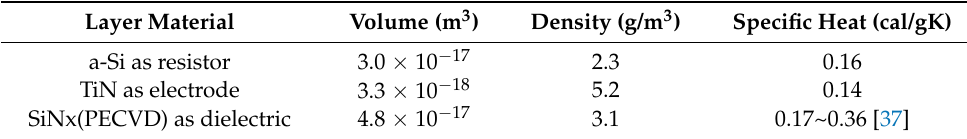
Table 2. The calculated heat capacity ranged from around 1.6 to 2.8 × 10 − 10 (J/K) and showed similar results to the measured values, proving the validity of this measurement method. Table 2. Layers and thermal properties [36] of the microbolometer pixel